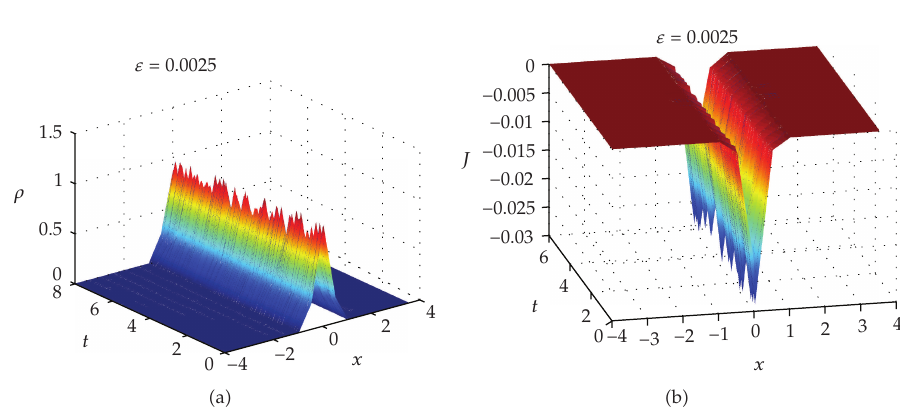
Figure 12: Numerical solutions of Example 5.3 by ED2/EP2 for the strong O (cid:3) 1 (cid:4) cubic defocusing nonlinearity (cid:3) λ (cid:6) 1 (cid:4) , ε (cid:6) 0 . 0025.